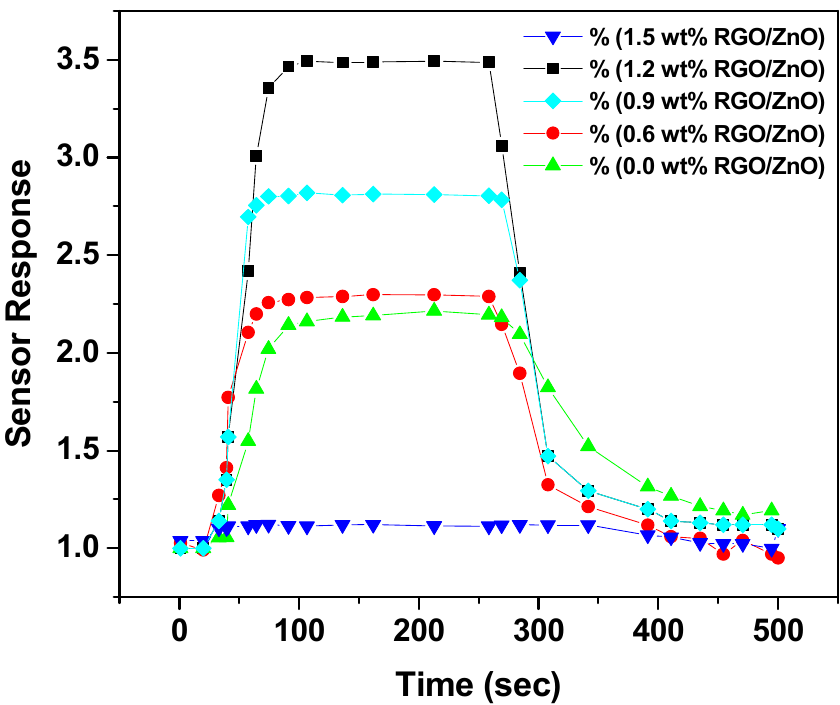
Figure 9. Sensor response vs time graph for ZnO and RGO/ZnO sensors towards 200 ppm of hydrogen at their respective optimum operating temperatures, i.e., 400 °C for ZnO and 150 °C for RGO/ZnO composite [126]. Copyright (2020), with permission from Elsevier.